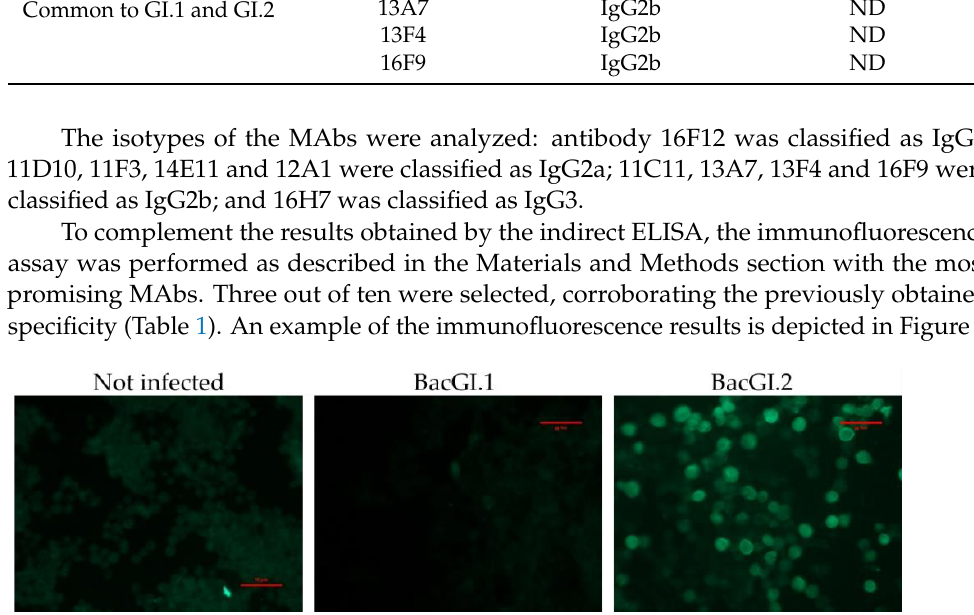
Figure 1. Detection of VP60 protein by the MAb 16F12 in non-infected and infected with